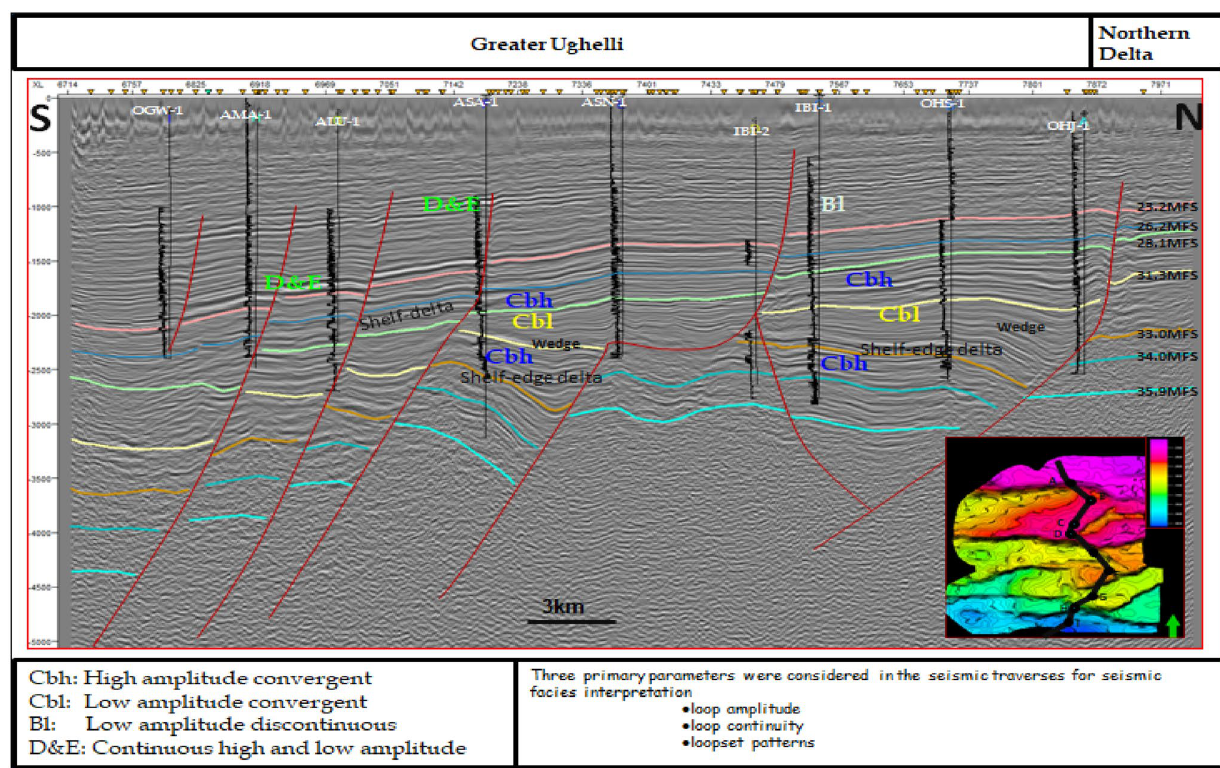
Fig. 6 Seismic stratigraphic section of the study area with seismic facies indicating the presence of Cbh, Cbl, Bl and D&E